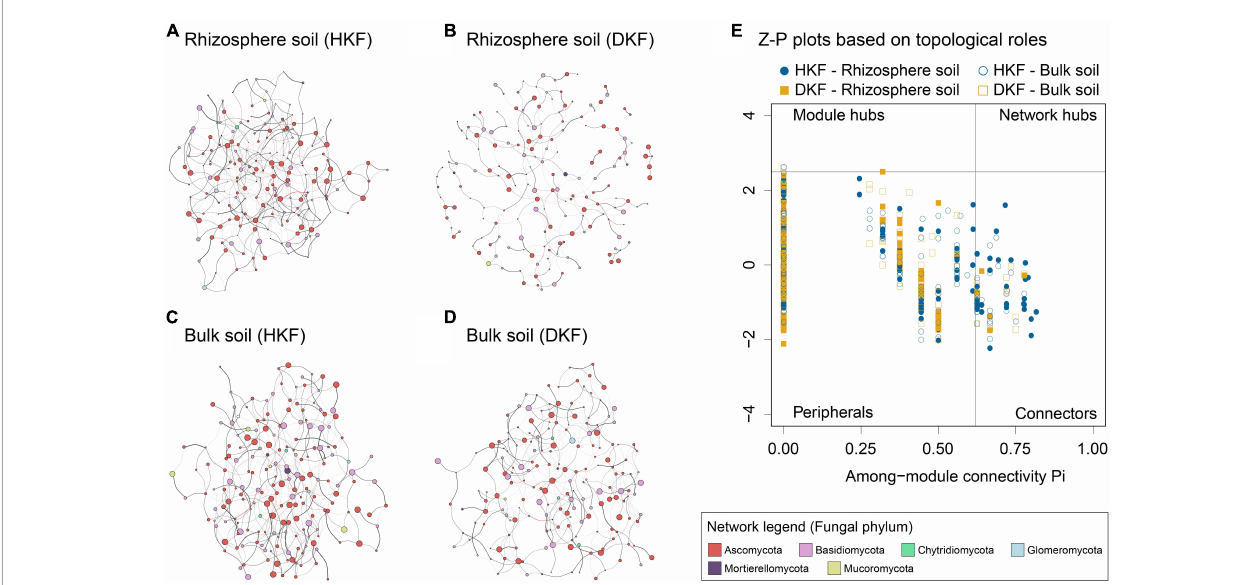
FIGURE4 The co-occurrence correlation network analysis of soil mycobiome for the (A,C) healthy Korean fir (HKF) and (B,D) dead Korean fir (DKF) groups. The relative abundance of taxa was represented through the node size and genera through the node color. Positive and negative correlations were indicated as black and red edges, respectively. The edge thickness shows correlation strength. (E) z -plot representing the topological roles of fungal genera based on within-module connectivity ( z i ) and among-module connectivity ( p i ). Each point shows a fungal genus in the HKF (blue) and DKF (yellow) soil communities. Filled and blank points indicate rhizospheric and bulk soil, respectively.